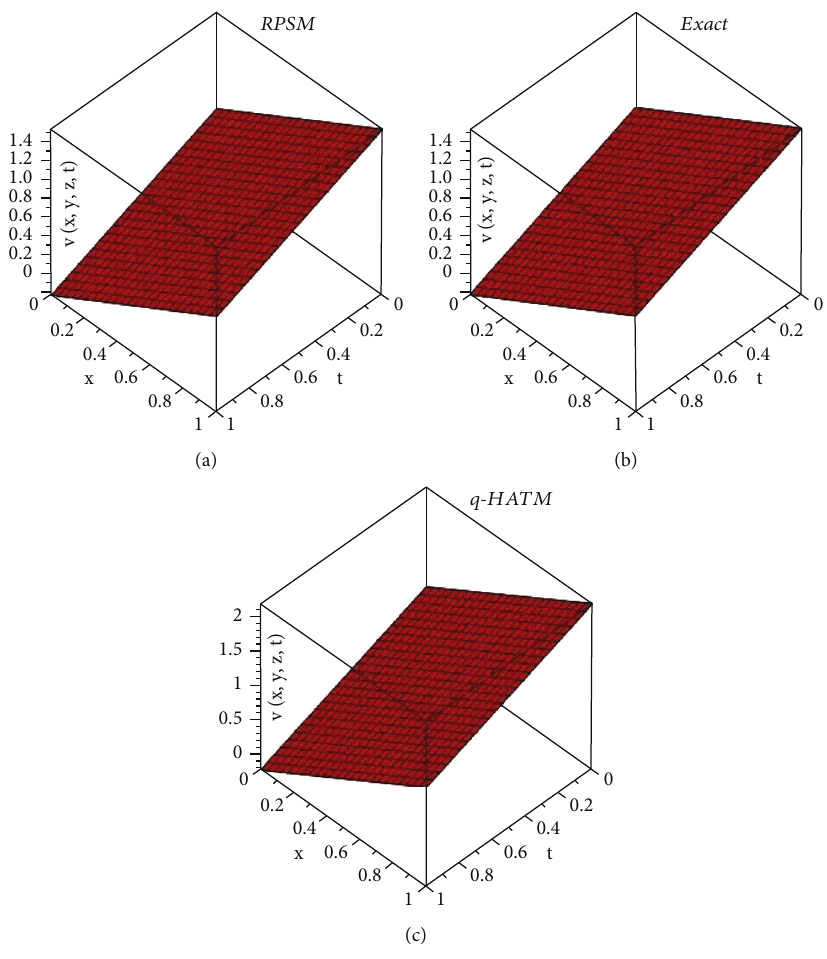
Figure 5: 3D-solutions plots of (a) RPSM, (b) Exact, and (c) q-HATM, at δ = 1 of Example 4.2.